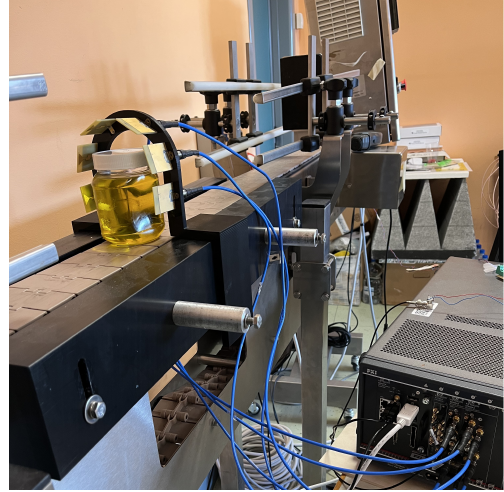
Figure 3. Microwave sensing